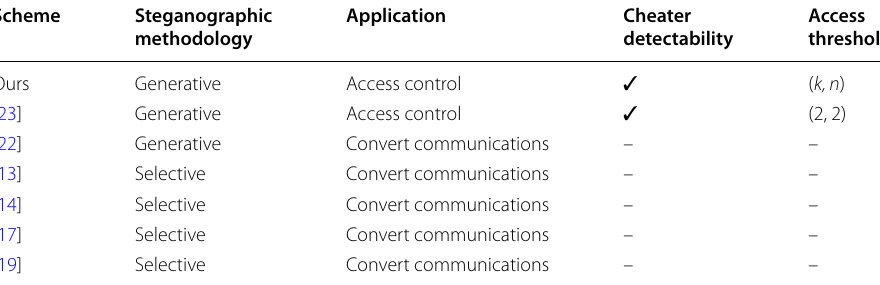
Table 4 Comparison of scheme characteristics